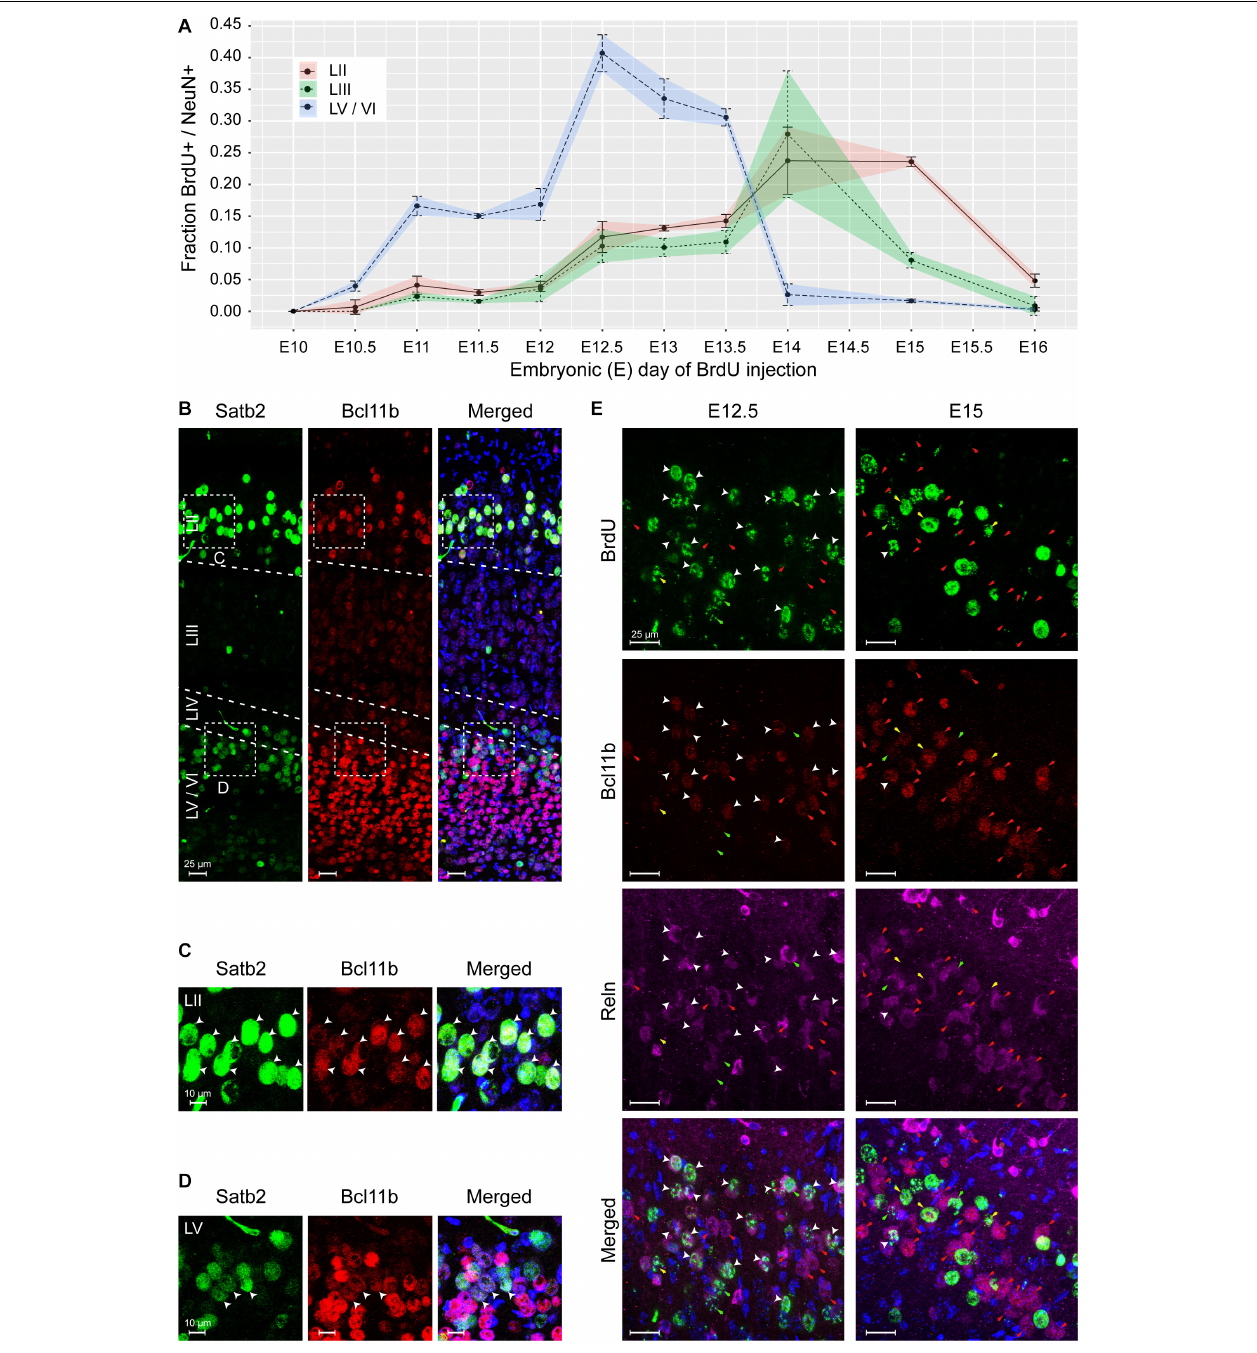
FIGURE 7 | The medial entorhinal cortex (MEC) emerges via parallel lamination events. Birth timing of layers in the MEC was established using Bromodeoxyuridine (BrdU) labeling of NeuN-positive (+) neurons born at embryonic day (E)10 to E16 and identification of early born neurons by expression of Satb2, Bcl11b, and Reln. (A) Quantification of NeuN+ neurons labeled with BrdU in layer (L)II, LIII, and LVa/b/VI, respectively, at the time of BrdU injection, shown as correlation of BrdU + /NeuN + fraction and injection time in gestation as embryonic day (E). Error bars denote the standard deviation. (B) Overview of Satb2 and Bcll1b expression in the medial entorhinal cortex at postnatal day (P)7. The upper-layer (UL) marker, Satb2 was expressed in the LII and LVa. The deep-layer (DL) marker Bcl11b, was expressed both in the DL and co-expressed with Satb2 in neurons in LII. Merged image additionally shows Hoechst (HO) staining. Scale bar 25 µ m. High magnification of UL (C) and DL (D) inserts from A, show Satb2 + and Bcl11b expression in LII and LV cells. White arrow heads point to cells with co-expression. Merged image additionally shows HO DNA labeling. Scale bar 10 µ m. (E) Co-expression of Bcl11b and Reln in cells in the LII newborn neurons at E12.5 and E15 (assessed by BrdU labeling). White arrow heads show cells with immunoreactivity for BrdU, Bcl11b and Reln. Red arrows point to cells co- expressing Bcl11b and Reln. Yellow arrows depict expression of Bcl11b in BrdU labeled cells. Green arrows depict expression of Reln in BrdU labeled cells. Merged image shows immunoreactivity of BrdU, Bcl11b, Reln, and HO. Scale bar 25 µ m.